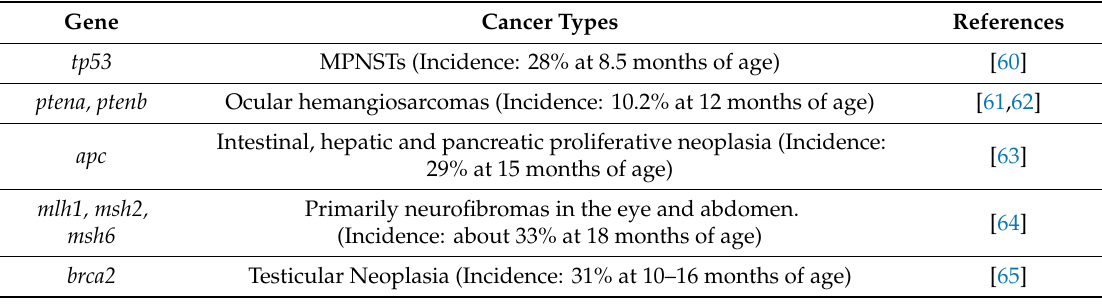
Table 3. Zebrafish mutants generated through the TILLING